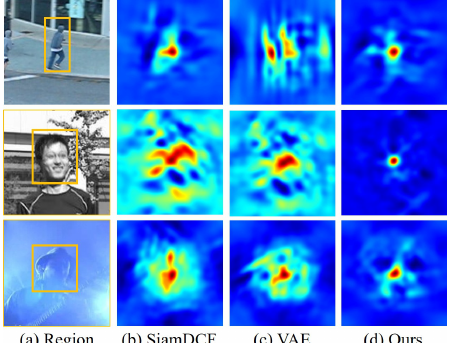
Figure 1. Response maps learned in different ways for correlation filters. ( a ) input images with a rectangular search region ( Jumping , Human4 , and Shaking , from top to bottom); ( b ) response maps of SiamDCF [17]; ( c ) response maps of our SiamDCF with a variational auto-encoder [18]; and ( d ) response maps of our method. Our method successfully removes the surrounding background clutters and focuses on the structure of the target, where the peak response value coincides with the true maximum correlation